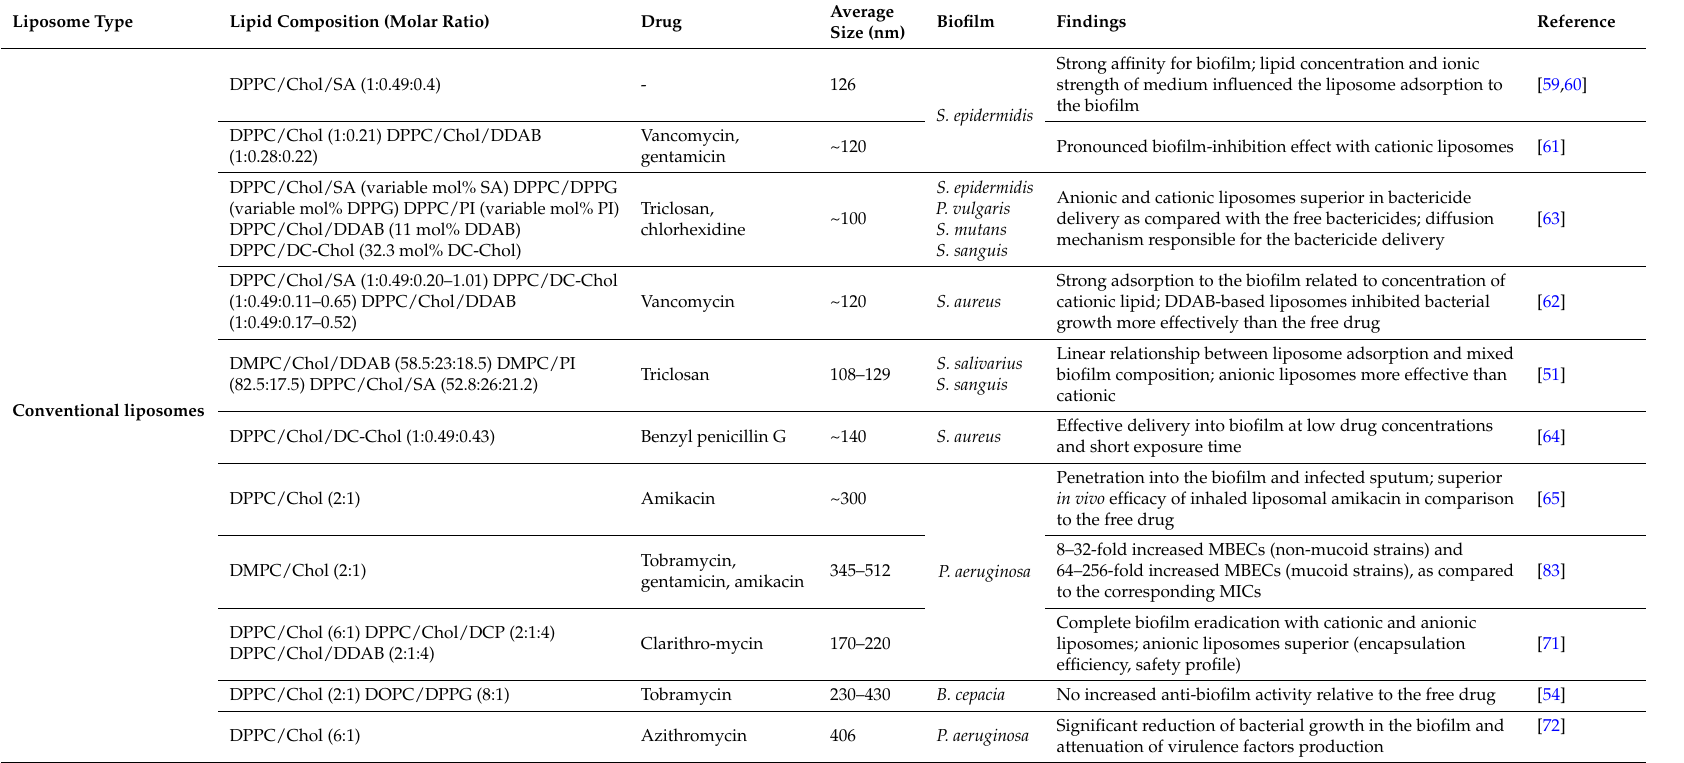
Table 1. Summary of the different types of liposomes investigated for delivery of antimicrobials to bacterial biofilms. Liposome Type Lipid Composition (Molar Ratio)